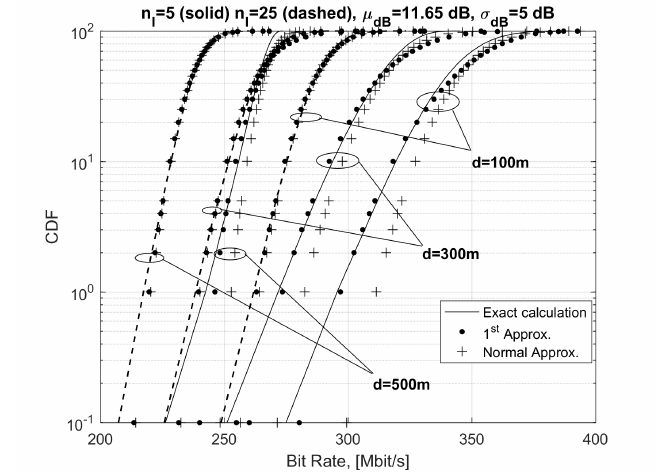
Figure 7. CDF of the bit rate for variable distance d and n I =